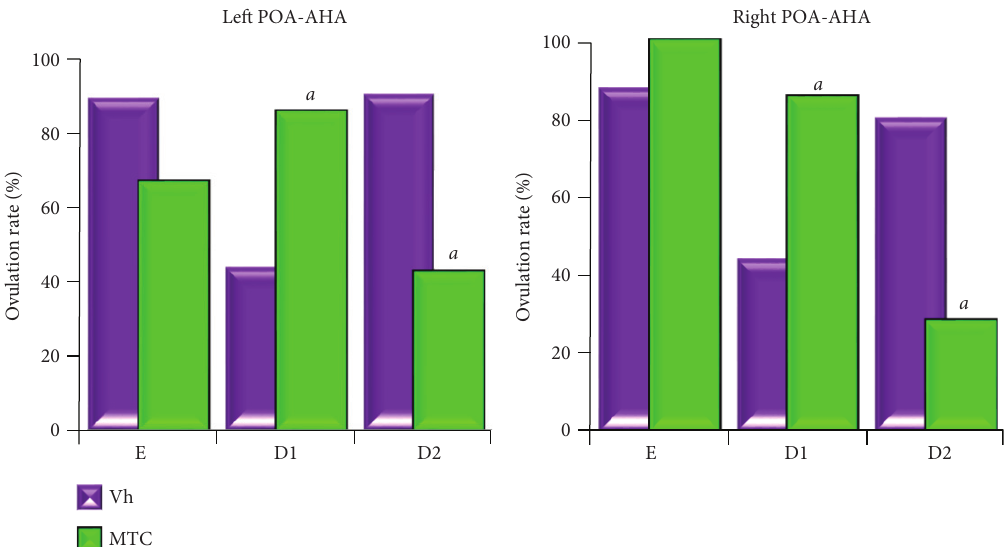
Figure 5: The e ff ects of vehicle (Vh) or methoctramine (MTC) microinjected in the left or right side of the POA-AHA region on ovulation. The ovulation rate (number of ovulating animals over total number of the treatment group) of rats microinjected with vehicle (Vh) or methoctramine (MTC) in the left or right POA-AHA at 13:00h on the day of oestrous (E), dioestrous-1 (D1), or dioestrous-2 (D2). a p < 0 05 versus the respective Vh group (chi-square